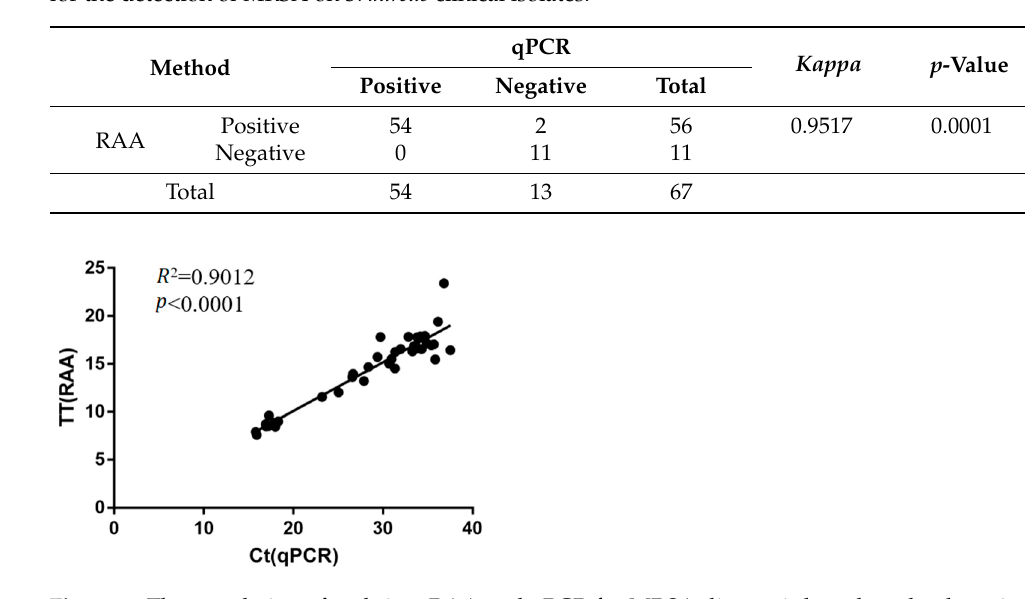
Figure 4. The correlation of real-time RAA and qPCR for MRSA diagnosis based on the detection results of 67 S. aureus clinical isolates. The threshold time (TT) values of real-time RAA at Y -axis and the cycle threshold (Ct) values of qPCR at X -axis were analyzed by linear regression analysis using GraphPad Prism software. The results from both assays were significantly correlated ( R 2 = 0.9012, p <